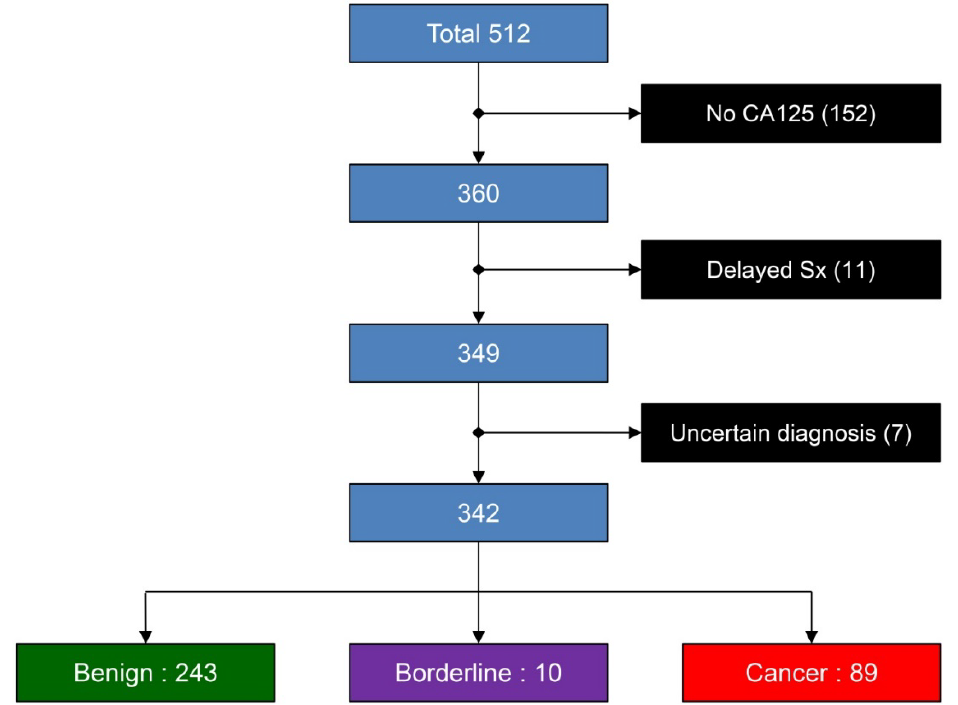
Figure 2. Flowchart of the cases scheduled for surgery because of adnexal masses. Table 1. Frequencies of the adnexal masses according to final diagnosis.